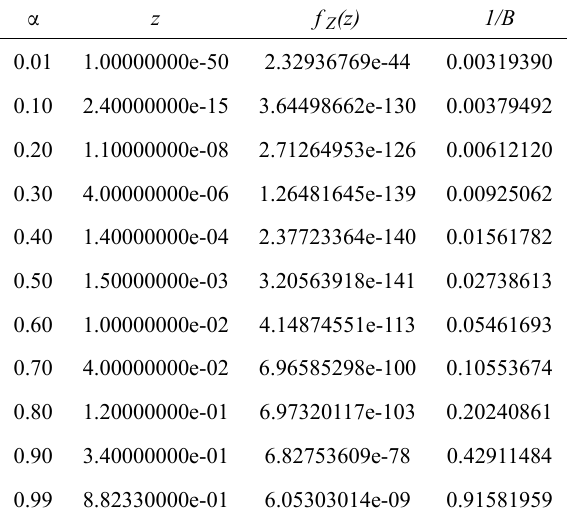
Early values, in the direction of increasing z, of α , z, f Z (z) and 1/B for which the Tweedie densities are calculated